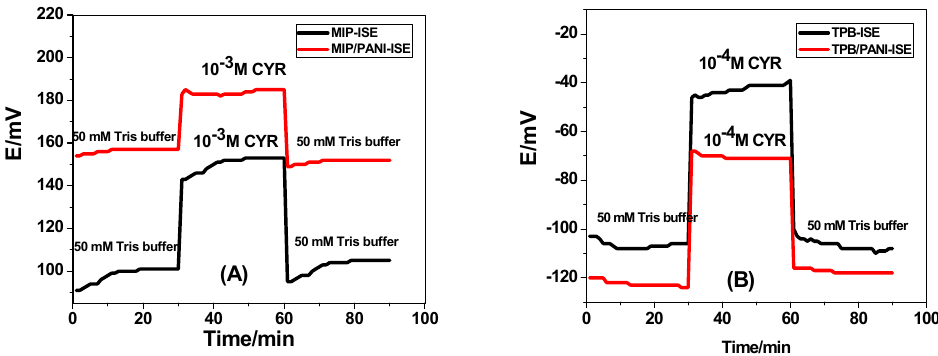
Figure 5. Water-layer tests for the CYR-ISE ( A ) MIP and ( B ) TPB, with/without PANI solid